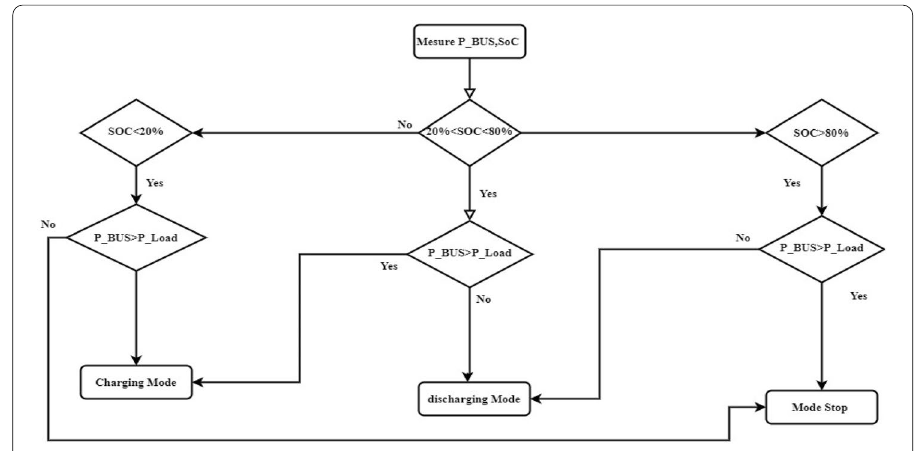
Fig. 11 Flowchart of energy management strategy